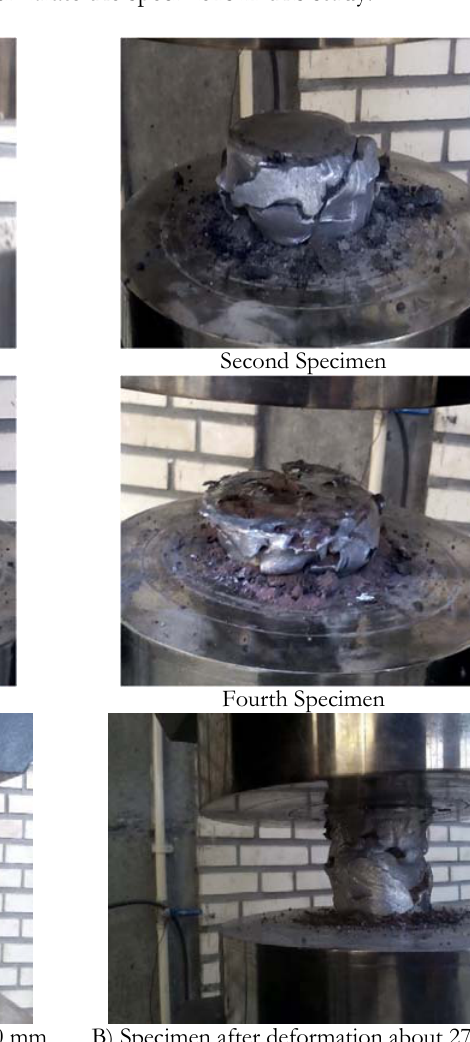
Figure 9: Experimental specimens in the pressure test .